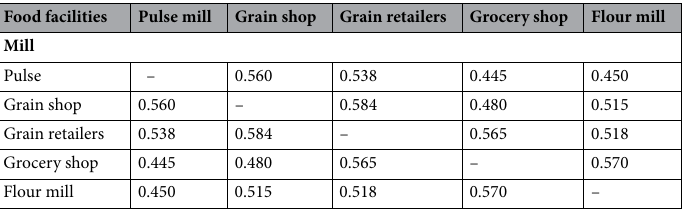
Table 2. Matrix Pearson’s correlation for the total population of Indian meal moth occurring in different food facilities at Rajshahi municipality area, Bangladesh during the five successive years